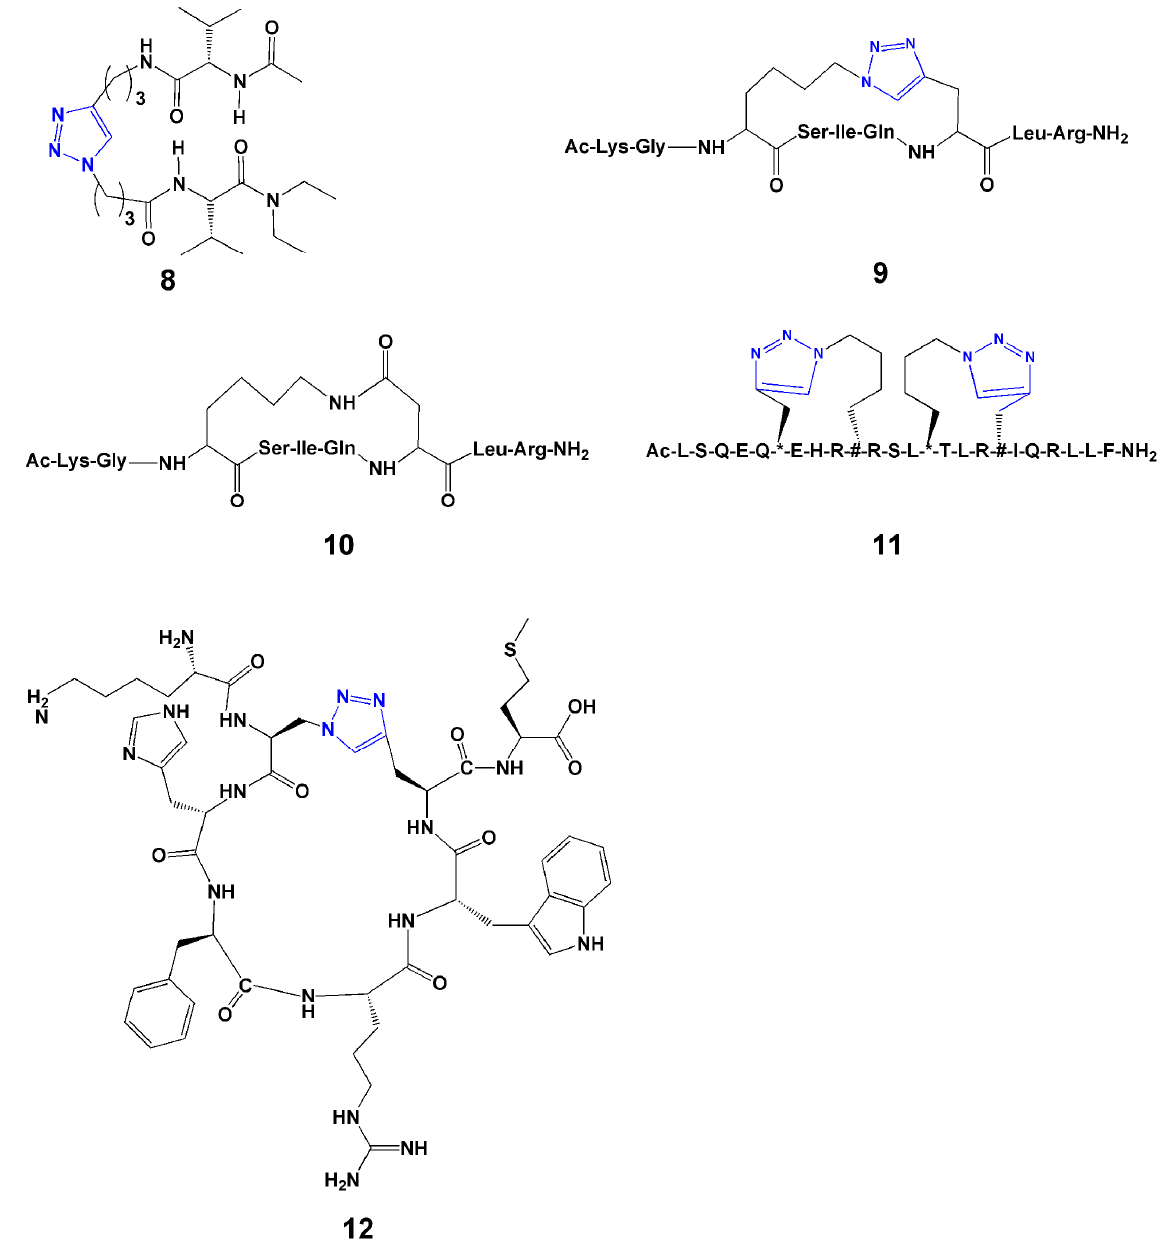
Figure 3. Selected examples of 1,2,3-triazoles used for secondary structure